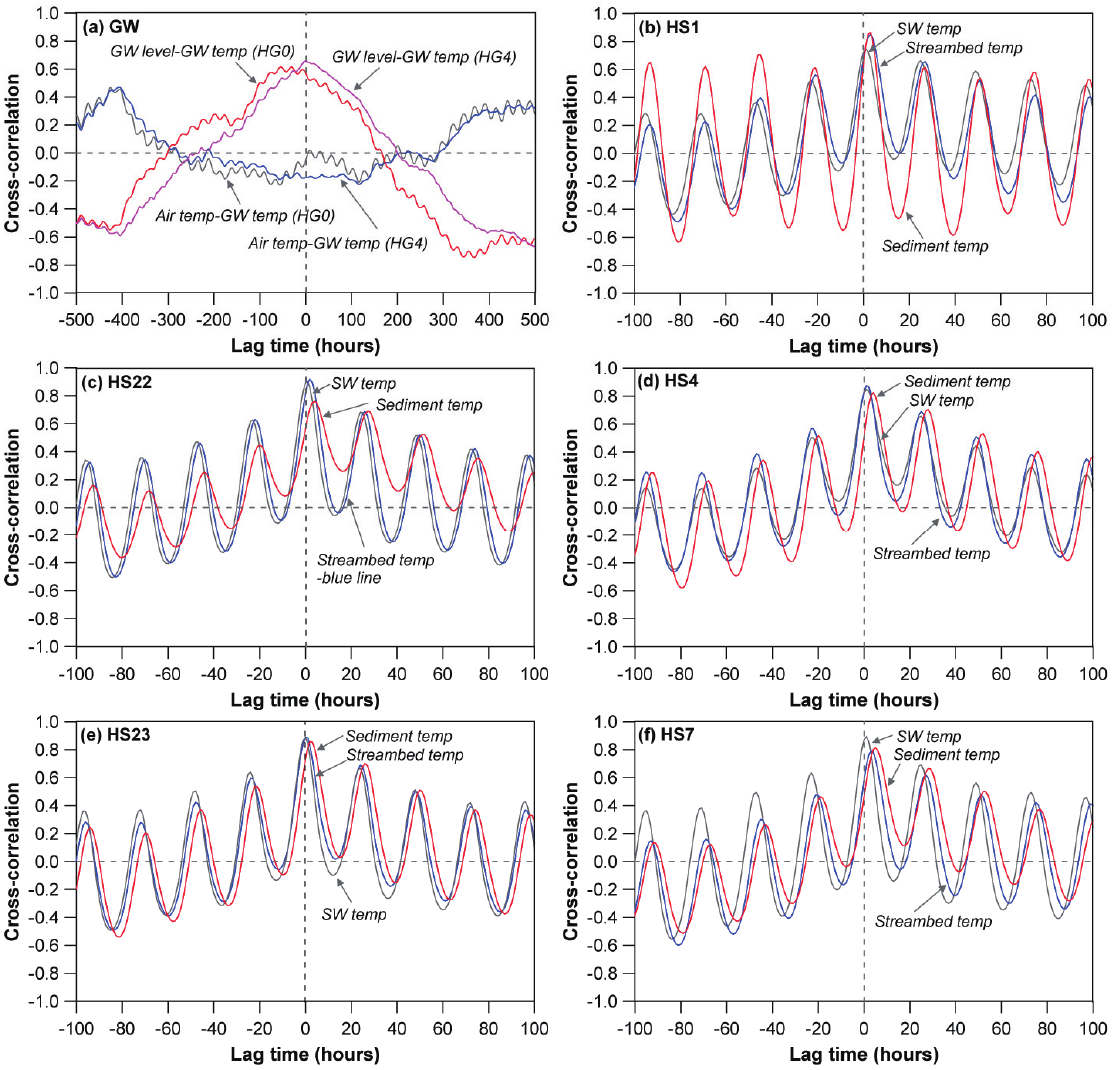
Figure 8. Cross-correlation (truncation = 100 hours, except for groundwater parameters at 500 hours) between the air temperature and groundwater, stream water, and streambed temperature. ( a ) GW; ( b ) HS1; ( c ) HS22; ( d ) HS4; ( e ) HS23 and ( f )